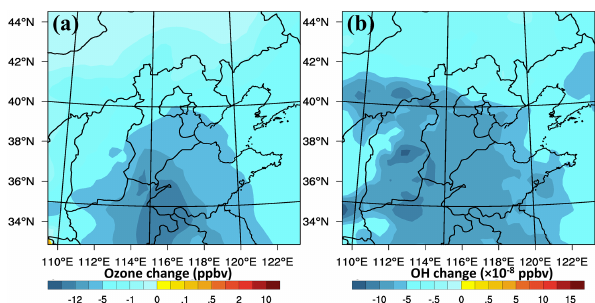
Figure 5. Daytime ozone (a) and daytime OH (b) changes due to NO x emission increases.